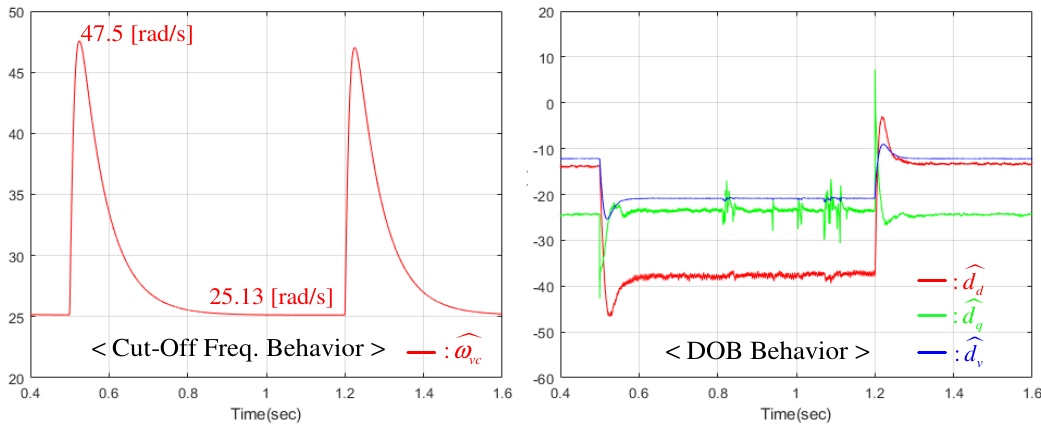
Figure 5. Cut-off frequency and DOB responses of proposed controller under DC-link voltage tracking control mode.